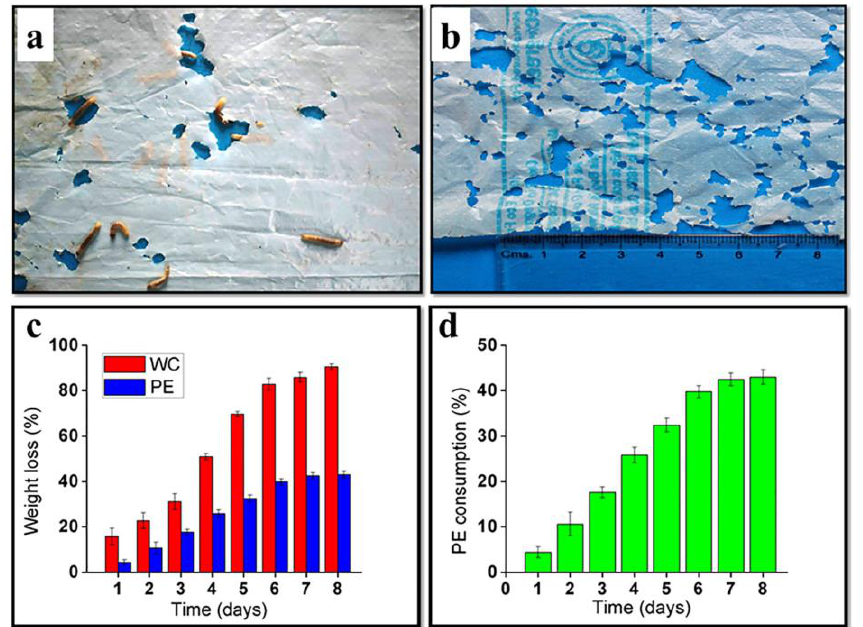
Figure 7. ( a ) Galleria mellonella larvae feeding on PE film. ( b ) Degraded PE film with holes after exposure to the lesser waxworm for 12 h. ( c ) Comparison of post-degradation weight loss percentage of waxcomb and PE after lesser waxworm consumption. ( d ) PE consumption over time, reprinted with permission from [40].